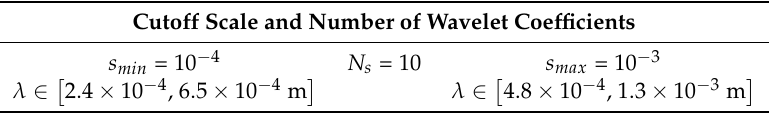
Table 6. Cutoff scale and number of wavelet